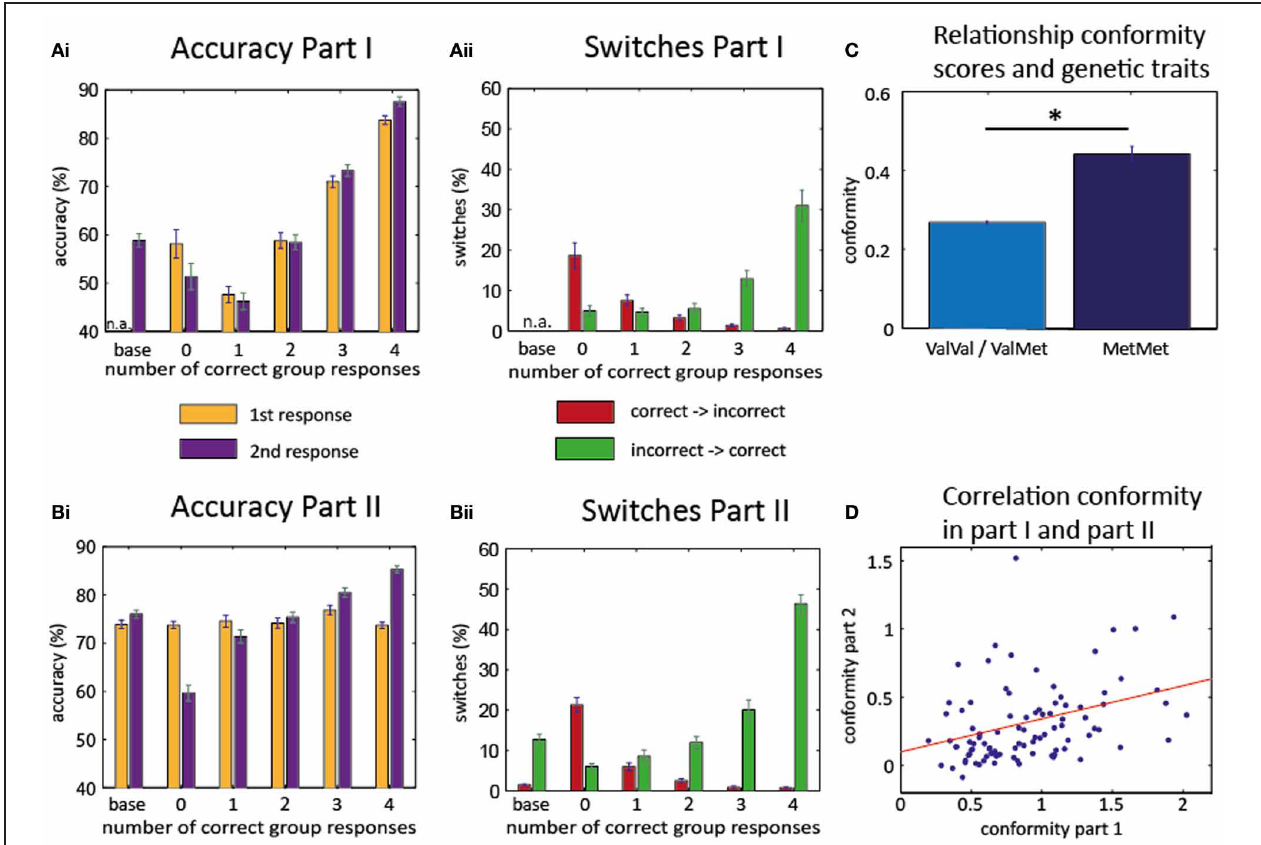
participant. Therefore, accuracy of first response and switches could not be evaluated for these trials (n.a.). (C) Association of conformity scores with genetic polymorphisms. Homozygous Met/Met-allele carriers show higher conformity scores than carriers of at least on Val-allele. (D) High correlation between conformity scores of the first and second part: subjects who behaved conformist in part I also exhibited conformity in part II. ∗ T ( 99 ) = − 2 . 4547, P = 0 .